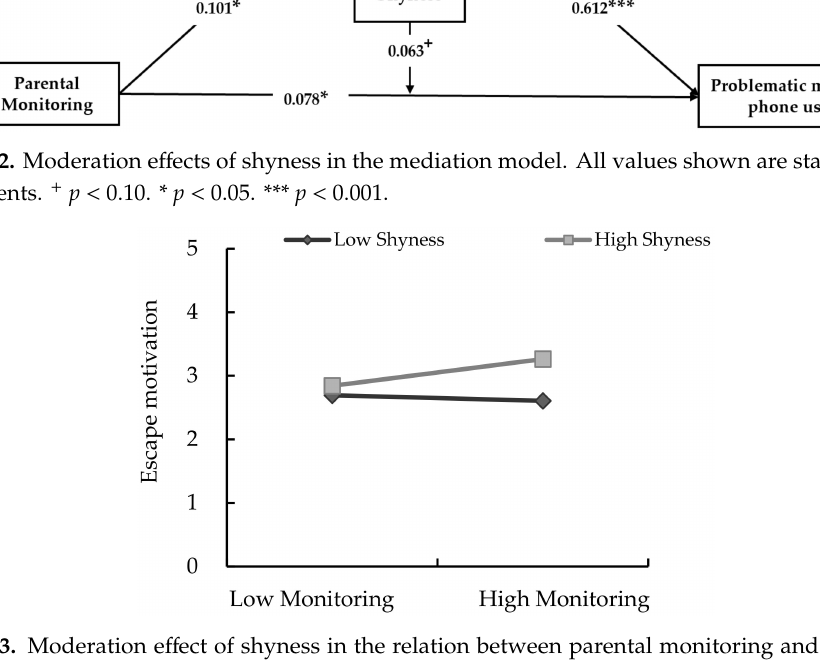
Figure 3. Moderation e ff ect of shyness in the relation between parental monitoring and children’s escape motivation.